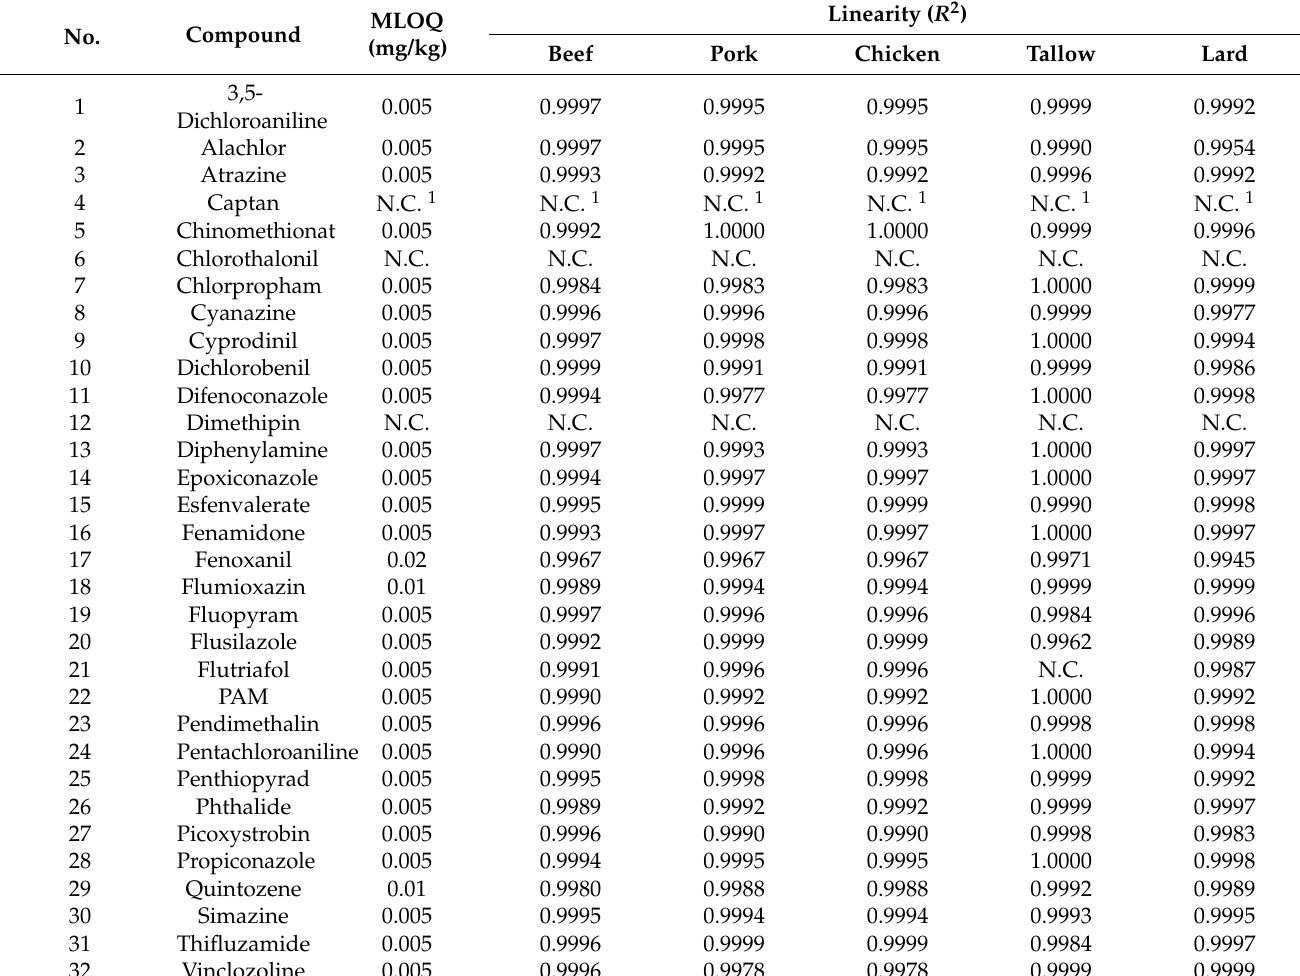
Table 1. Method limit of quantification and linearity for the 32 compounds in the